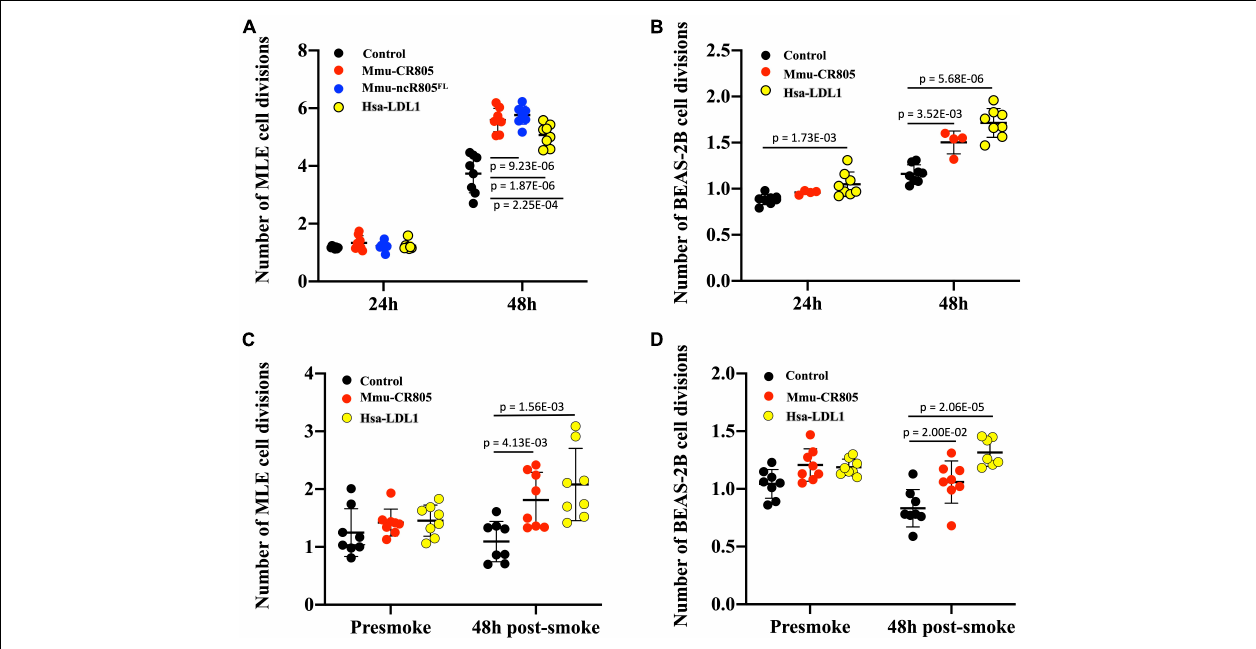
FIGURE 2 | RNA oligos containing the conserved regions of mouse and human orthologs (mmu-CR805 and hsa-LDL1, respectively) demonstrate biological activity similar to that of the full-length ncR-805 in MLE12 and BEAS-2B cells. The MLE12 (A,C) and BEAS-2B (B,D) cells were transfected with non-targeting RNA, mmu-CR805, or hsa-LDL1. The MLE12 cells were also transfected with mmu-ncR-805 FL . (A,B) Growth rates of cells 24 and 48 h post-transfection. (C,D) Growth rates of cells post-stress. Twenty-four hours post-transfection, the cell numbers were counted and the cells were exposed to 10% of CSE for 30 min, washed, and allowed to recover in their respected fresh media. Forty-eight hours post-exposure, the cell numbers were counted